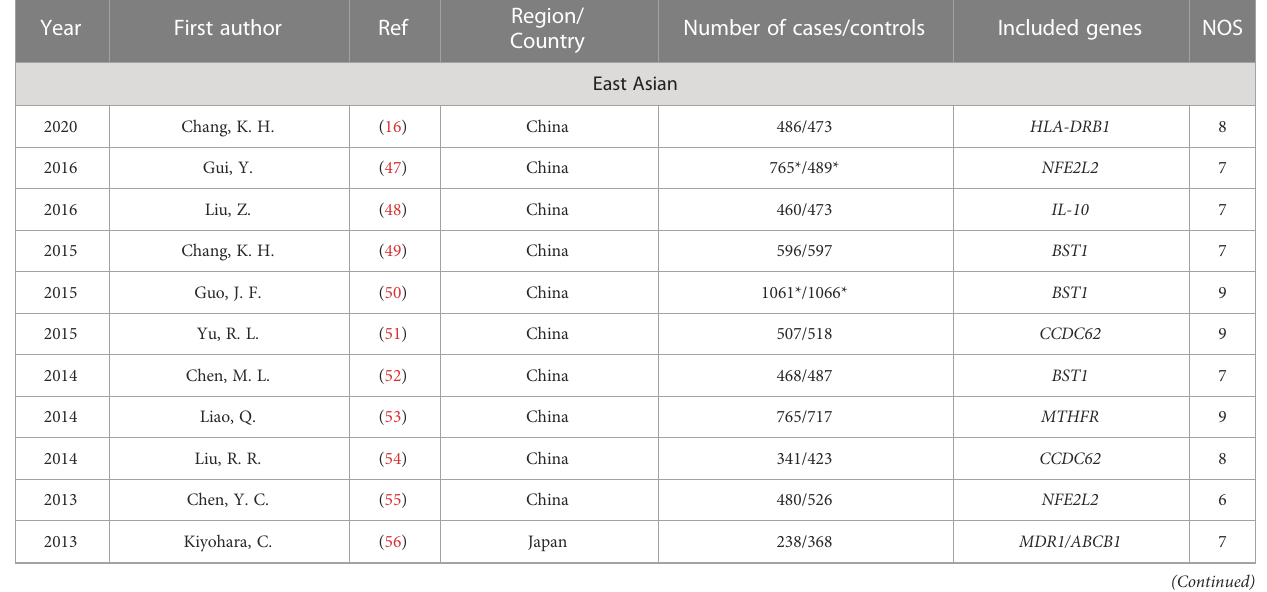
TABLE 2 The characteristics of all included publications for quantitative